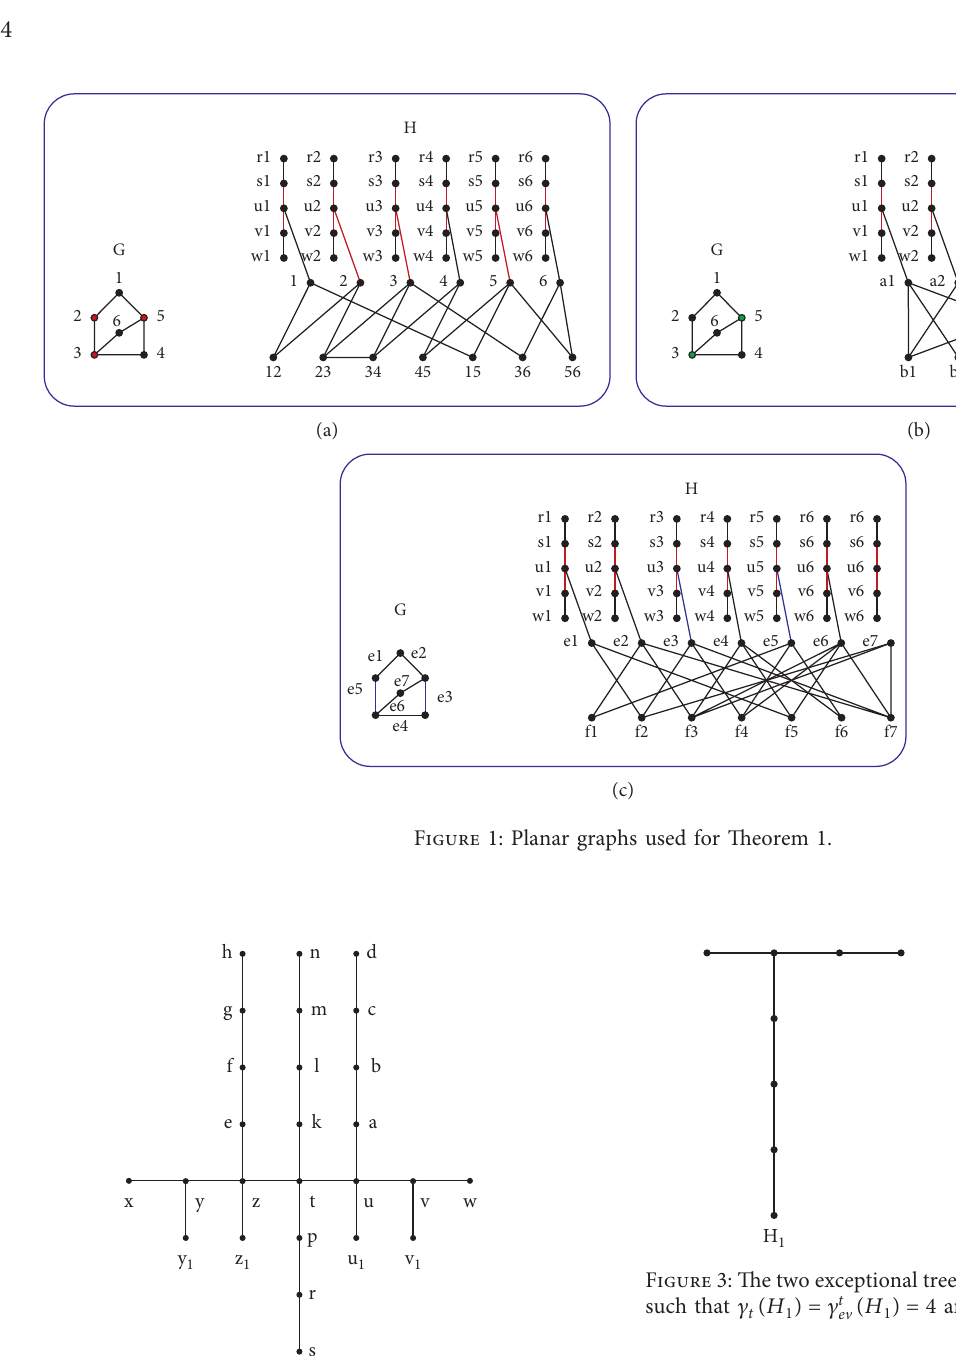
Figure 2: A tree T ∈ F which is obtained from T adding the vertices y P